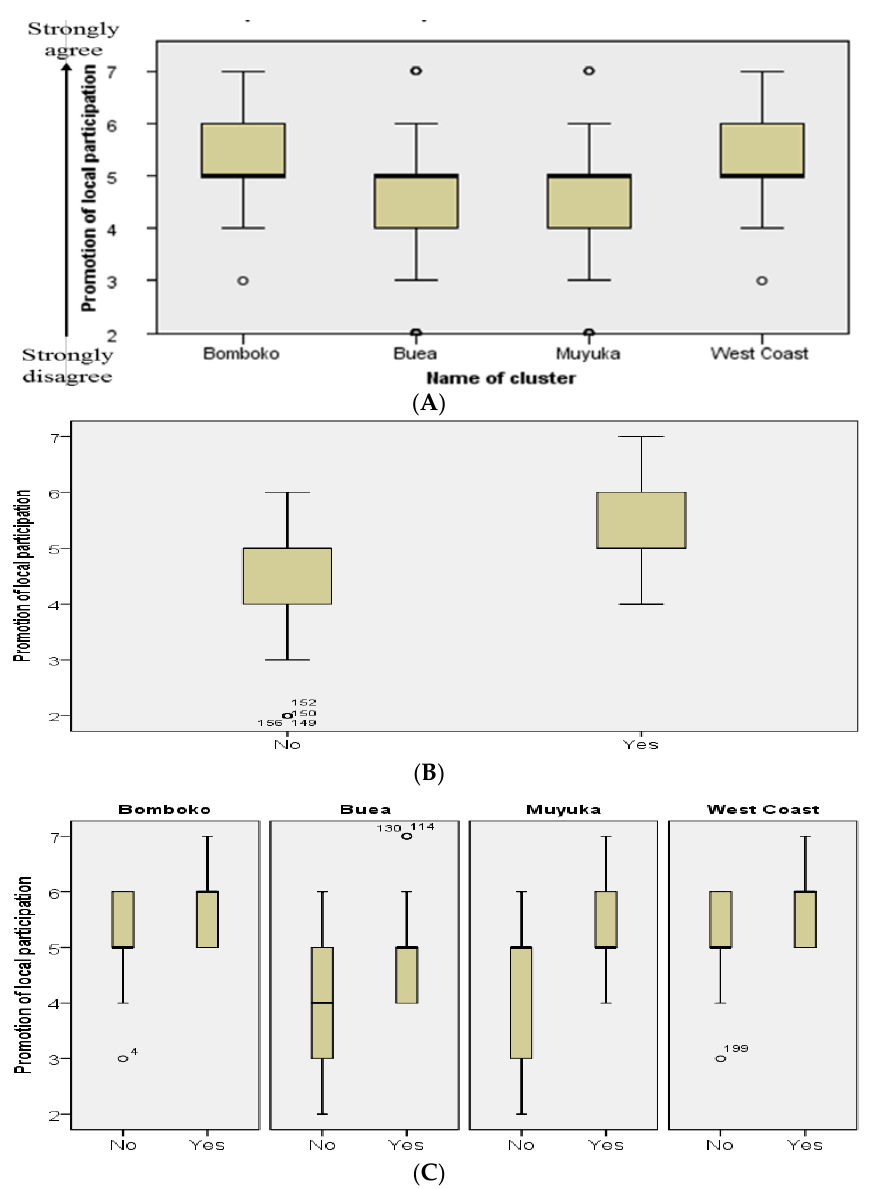
Figure 7. A Kruskal–Wallis plot showing variance in promoting local participation within clusters ( A ); and t -tests showing how the perception of wanting to promote local participation influences participation in MCNP clusters ( B ) and within each cluster ( C ).